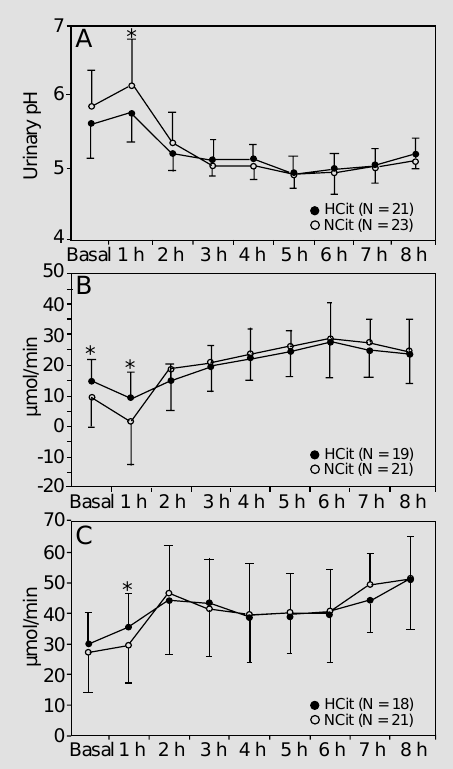
Figure 1 - Effect of ammonium chloride administration on uri- nary pH (A), titratable acidity (B), and ammonium excretion (C) by patients with hypocitraturia (filled circles) and normocitra- turia (blank circles). Data are re- ported as means ± SD for 18-23 measurements for each group. *P<0.05 (Student t